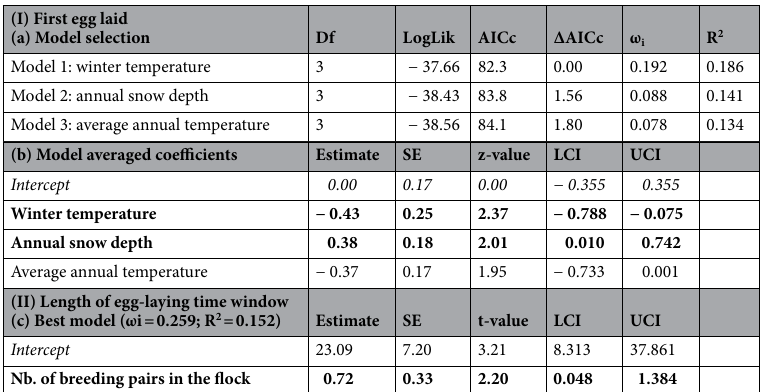
Table 1. Linear effects model for (I) the first egg laid within the flock; and, (II) the length of the egg-laying time window (measured as the timespan between the dates of the first egg laid by the first pair and the first egg laid by the last pair within the greylag geese flock) over 29 years (1990–2018) in the Alm valley, Austria, in relation to weather and the number of pairs attempting to breed within the flock. (a) Model selection results compared by Akaike’s Information Criterion for small samples (AICc) against each other and model weight (ω i ) presented up to ΔAIC c < 2.0; and (b) Model-averaged coefficients from a set of 3 models for the first egg laid presented as estimated values ± (unconditional) SE, lower and upper 95% CIs; confidence intervals of parameter estimates not including zero (i.e., considered significant) are displayed in bold. And (c) best model for the length of the egg-laying time window featuring the number of breeding pairs in the flock. Note that all quantitative input variables were scaled and centred. Null model ranked (I) 10th [Akaike’s information criterion corrected for small sample size (AICc) = 191.7, ΔAICc = 3.47]; and, (II) 3rd (AICc = 224.0, ΔAICc = 2.29). Model weights based on complete list of candidate models (n = 32).